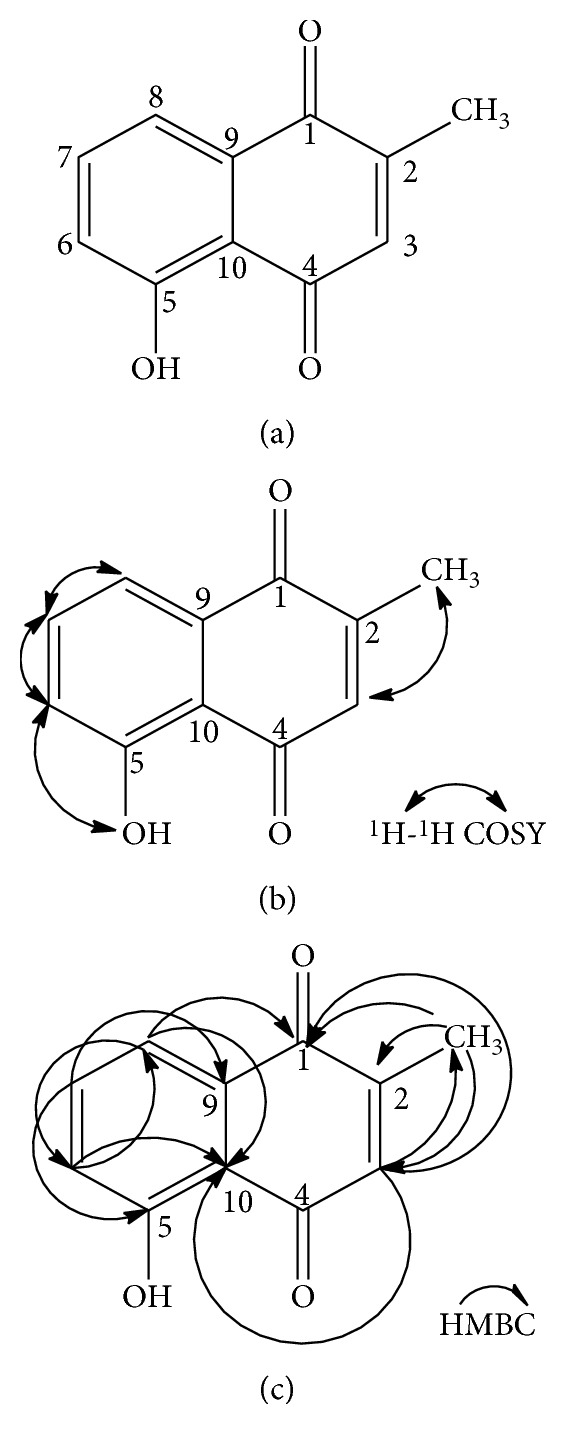
(a) Plumbagin. (b) 1H-1H COSY of plumbagin. (c) Key HMBC correlations of plumbagin.